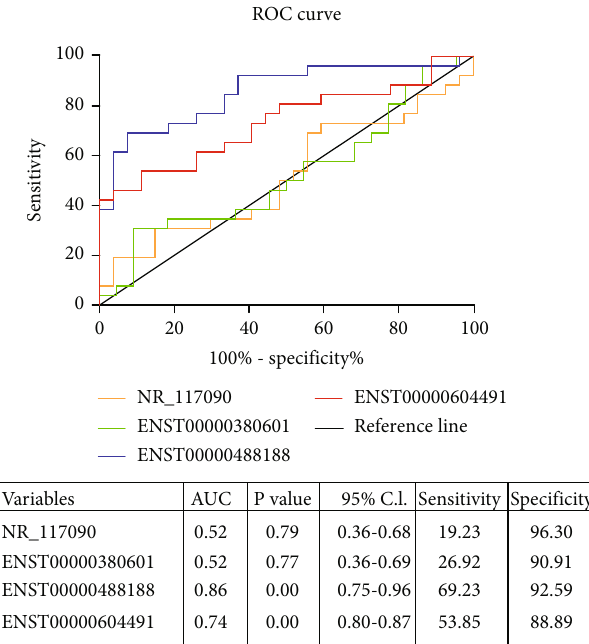
Figure 5: ROC curve analysis was performed to assess the diagnostic value of veri fi ed lncRNAs (NR_117090, ENST00000380601, ENST00000488188, and ENST00000604491). The evaluation indicators included AUC, p value, 95% C.I., sensitivity, and speci fi city.